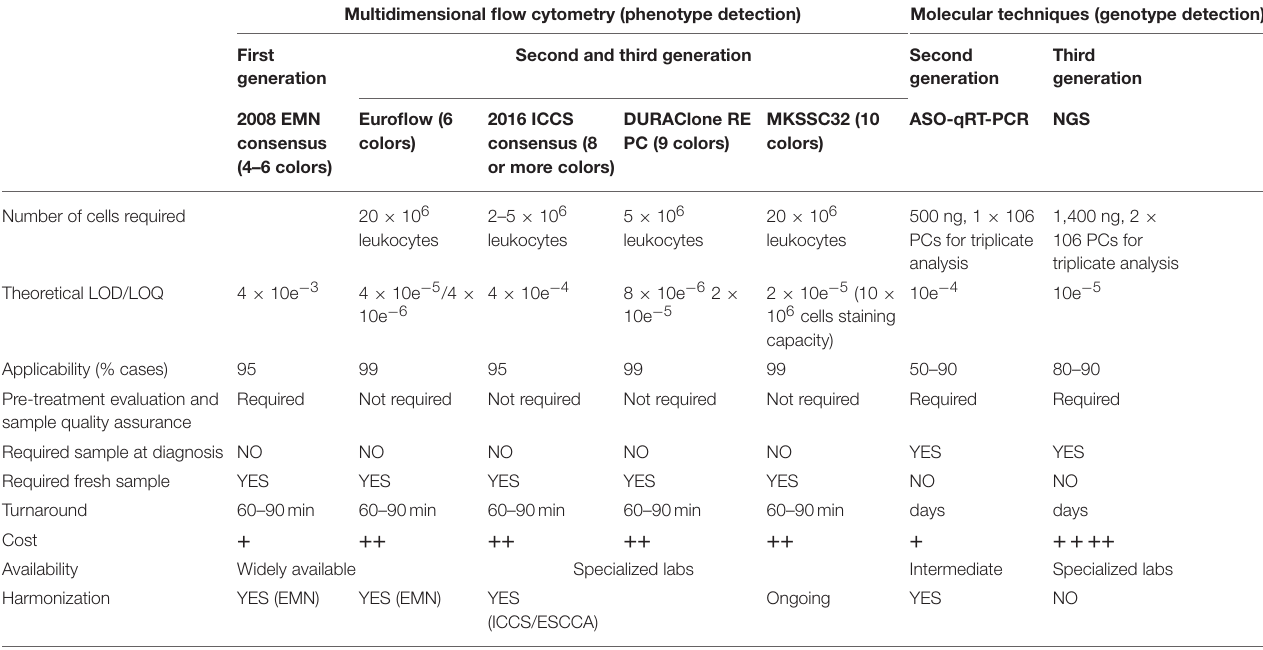
TABLE 2 | Comparison between different techniques to detect MRD in